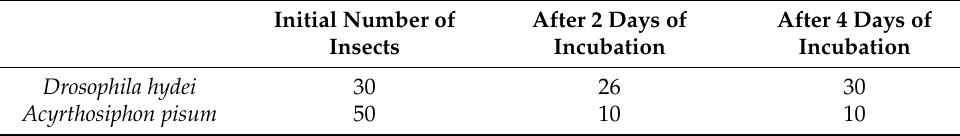
Table 2. Number of insects found in the plant funnels after 2 and 4 days of incubation.